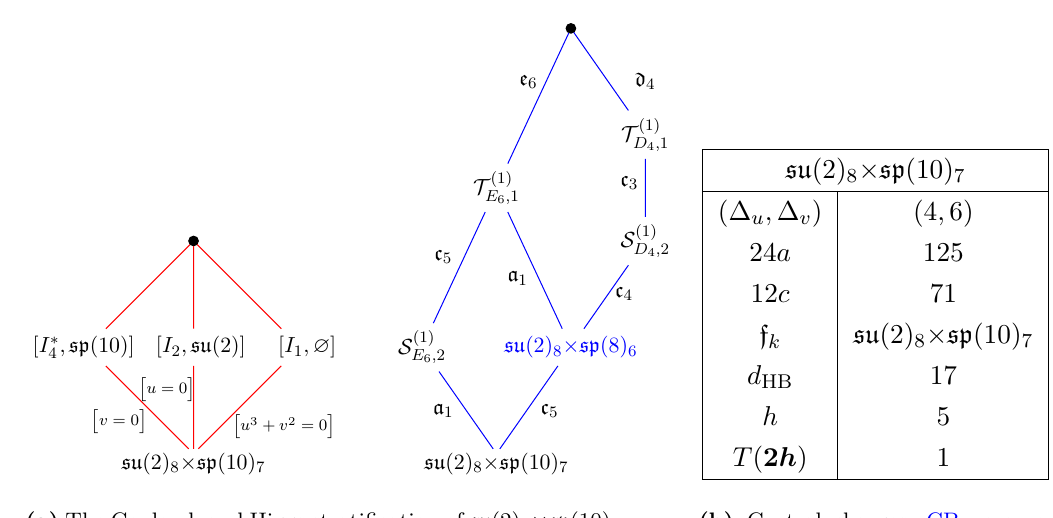
Figure 29. Information about the su (2) 8 × sp (10) 7